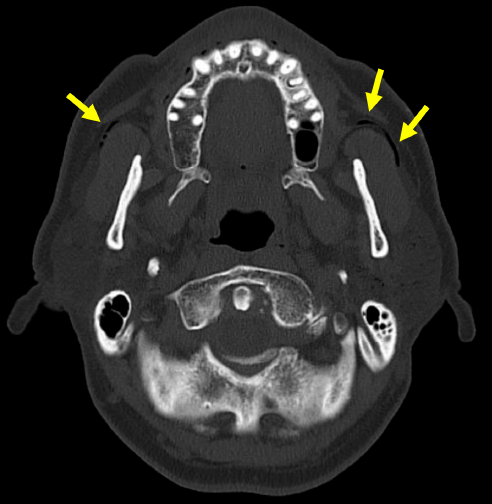
Figure 3. Air in the bilateral parotid glands and ducts (yellow arrows) in an axial-section computed tomography (CT) scan.